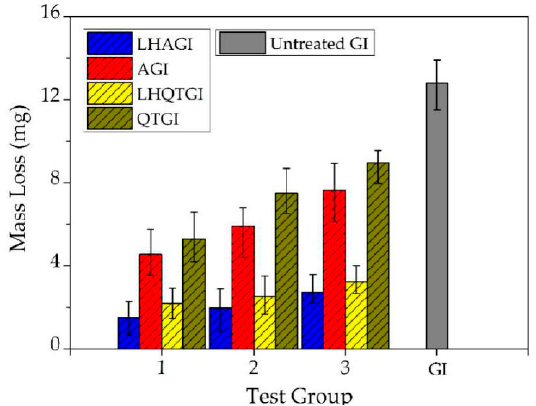
Figure 5. Mass loss of GI specimens after complete sliding wear test (Reprinted from ref. [42]).